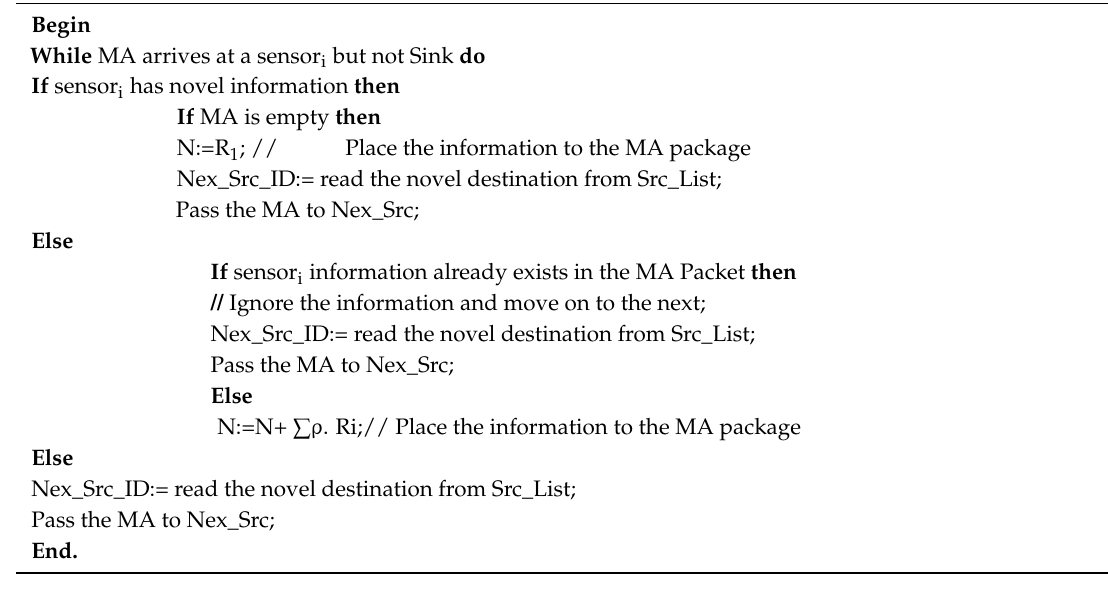
Algorithm 2. Pass the MA among the SNs.